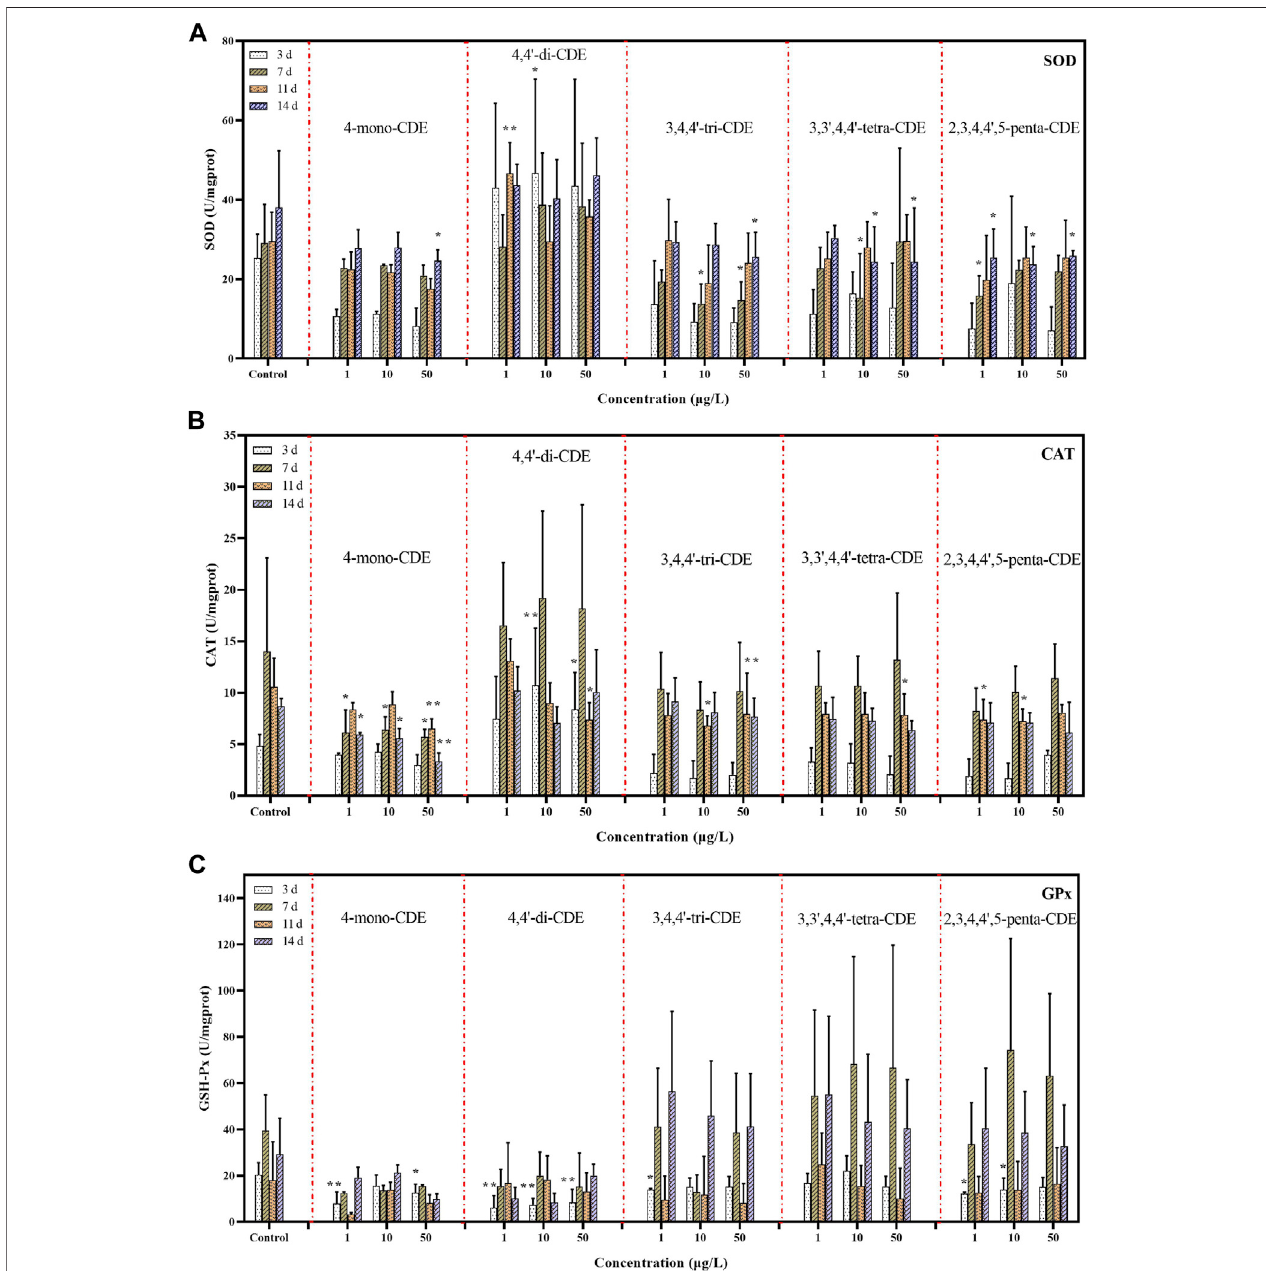
FIGURE 2 | The effects of PCDEs on the antioxidant defense system. SOD (A) , CAT (B) , and GPx (C) in zebra fi sh liver.